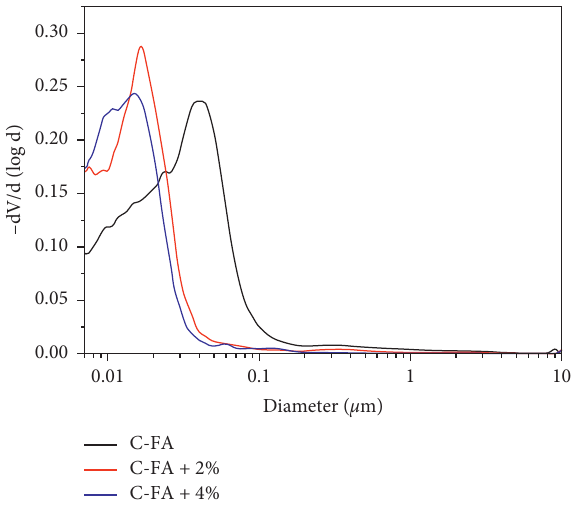
Figure 5: Pore size distribution of C-FA with